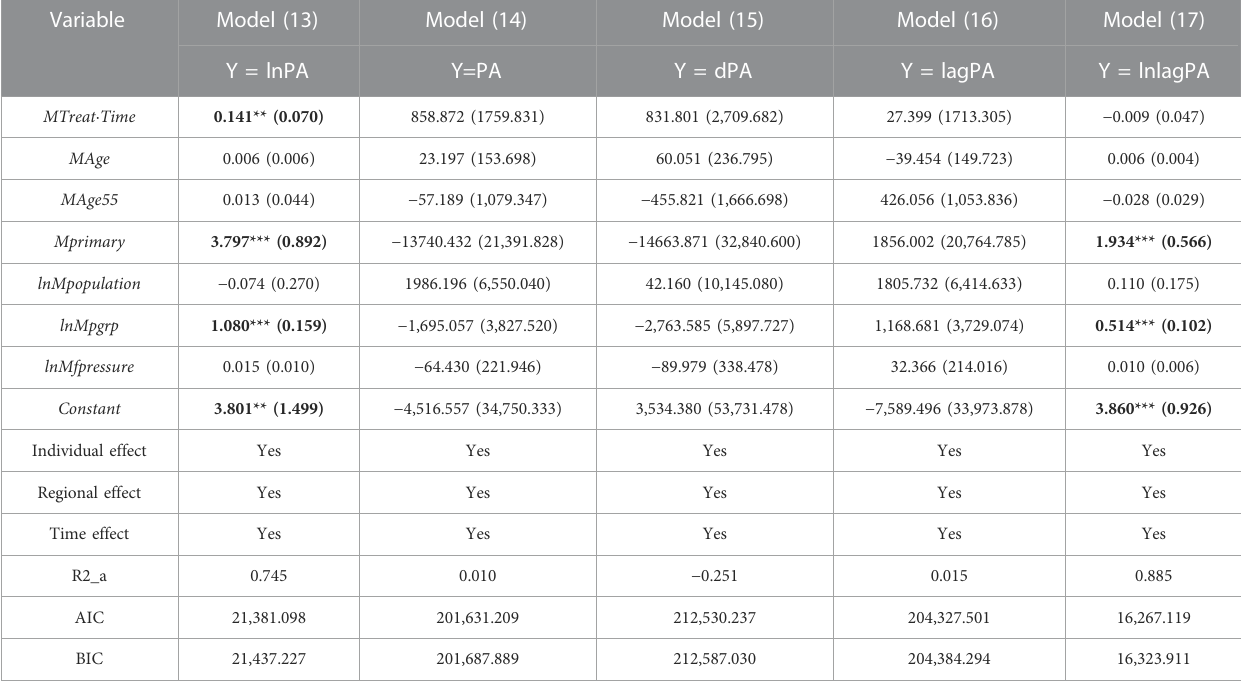
TABLE 4 Estimation results of the robustness